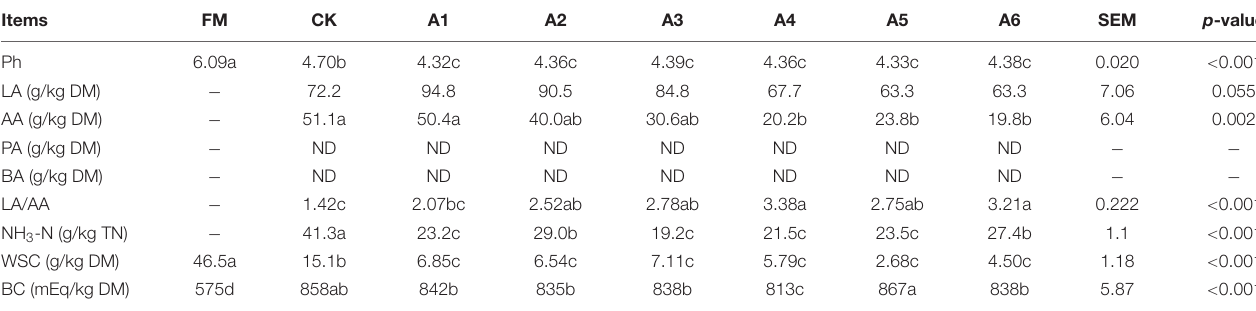
TABLE 1 | Fermentation quality, water-soluble carbohydrates (WSC), and buffering capacity (BC) of alfalfa silages ( n = 4).